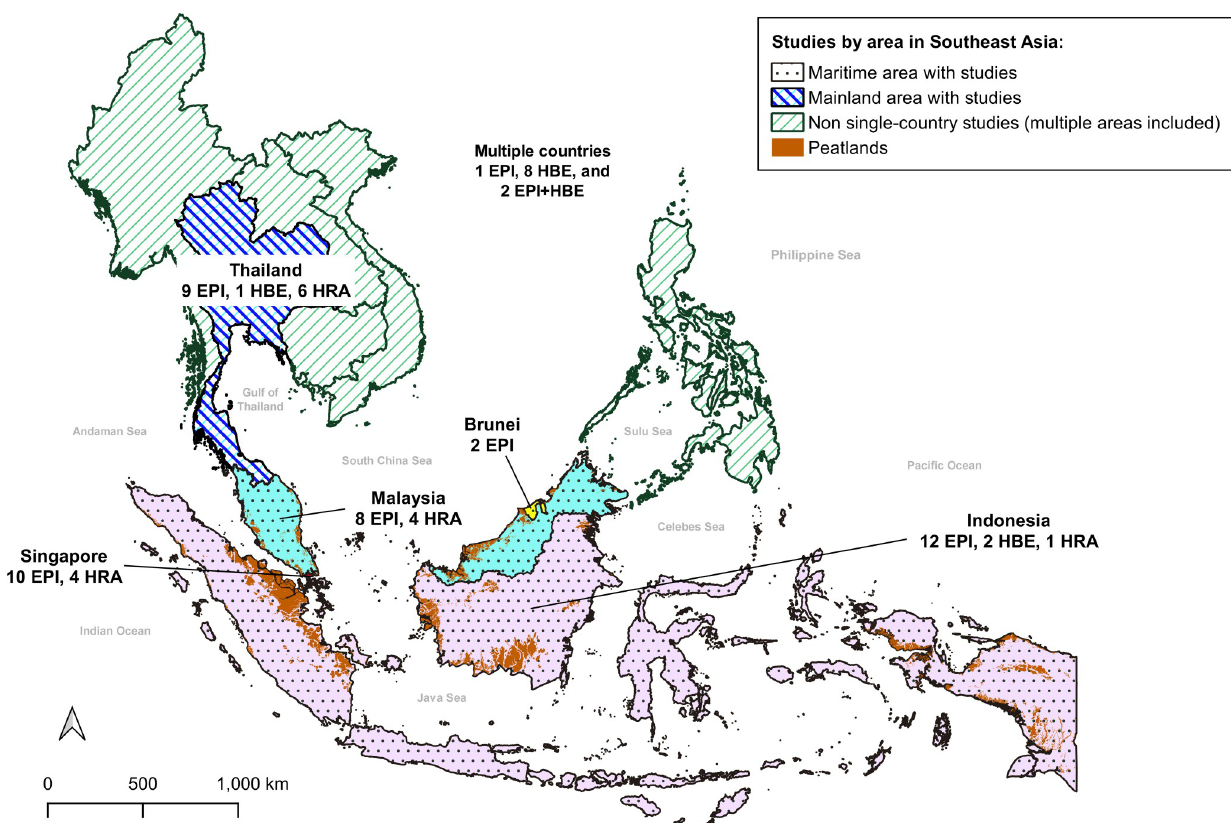
Fig 2. Map of countries where studies were conducted (Southeast